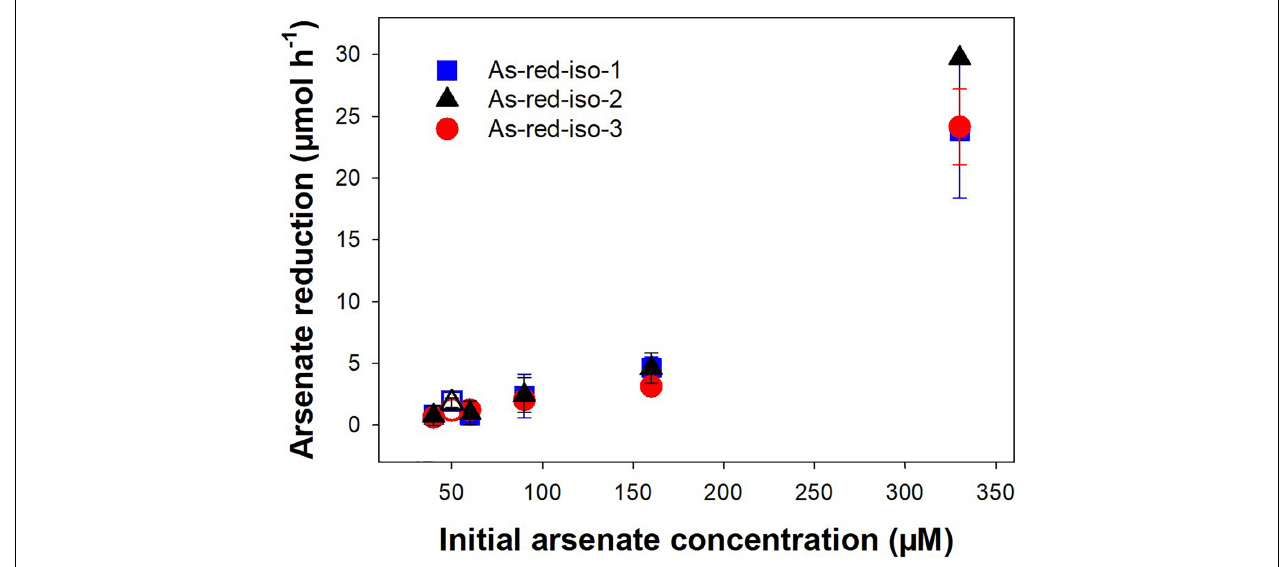
FIGURE 8 | Effect of initial arsenate concentration on arsenate reduction rates in arsenate-respiring microorganisms isolated from peat soil. Strains were incubated in medium for arsenate-respiring microorganisms supplemented with 45 µ M to 330 mM arsenate or artificial mine water supplemented with 50 µ M arsenate at 20 ◦ in the dark. Rates were normalized against the OD 660 nm of the first sampling timepoint. Mean values and standard errors of three replicates are shown. Closed symbols = incubation in medium for arsenate-respiring microorganisms, open symbols = incubation in artificial mine water.